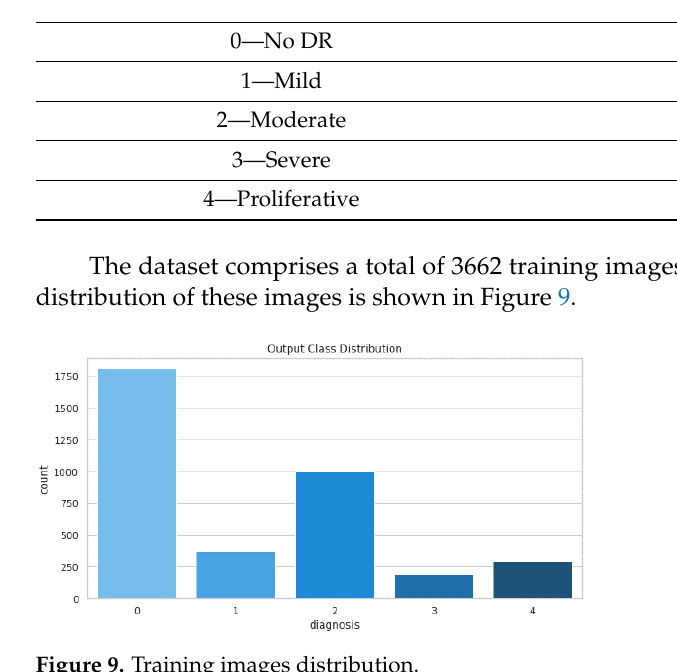
Figure 9. Training images distribution.